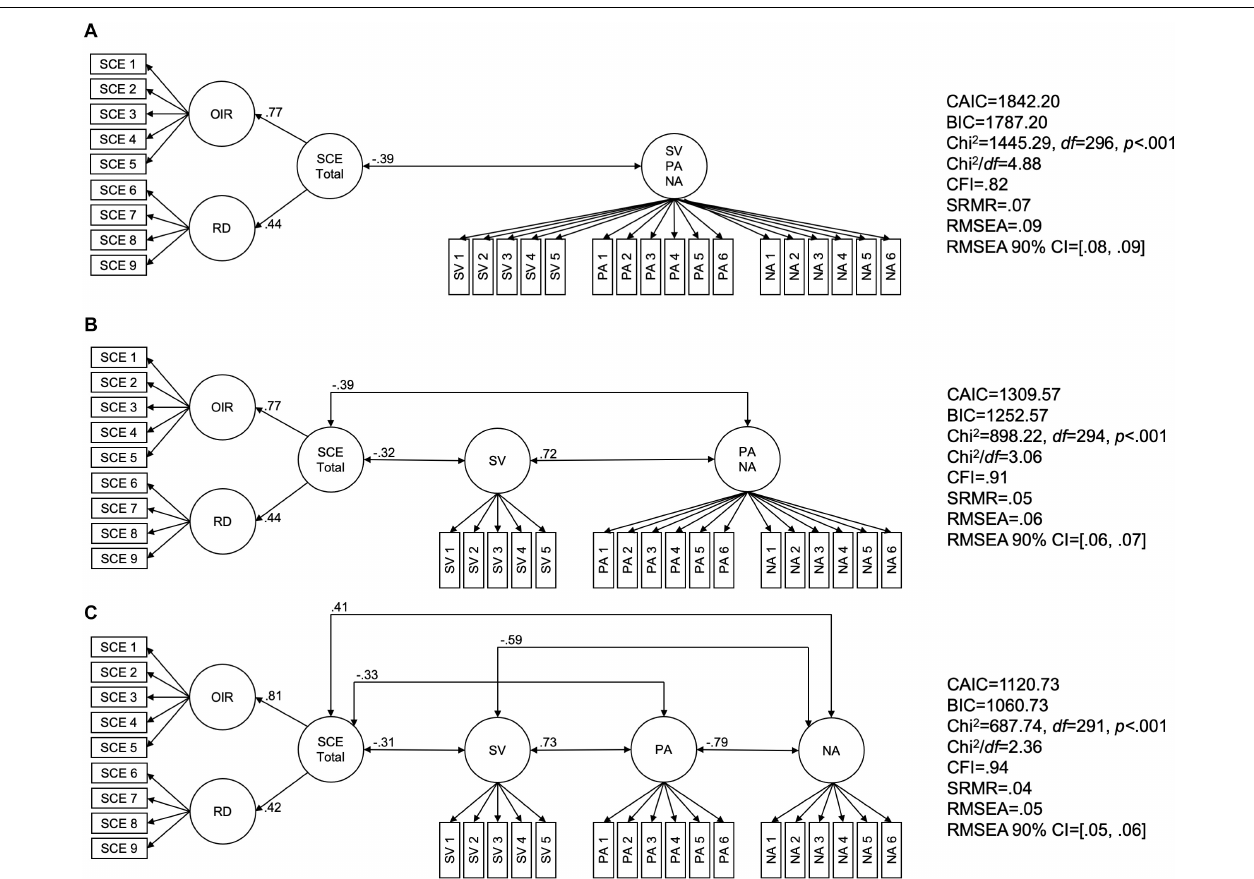
FIGURE 2 | Model tests applying confirmatory factor analyses with AMOS 26. Maximum likelihood estimation was applied. Depicted are the standardized regression weights and correlations, which were all significant at p < 0.001. (A) Subjective vitality, positive affect, and negative affect are combined within one common